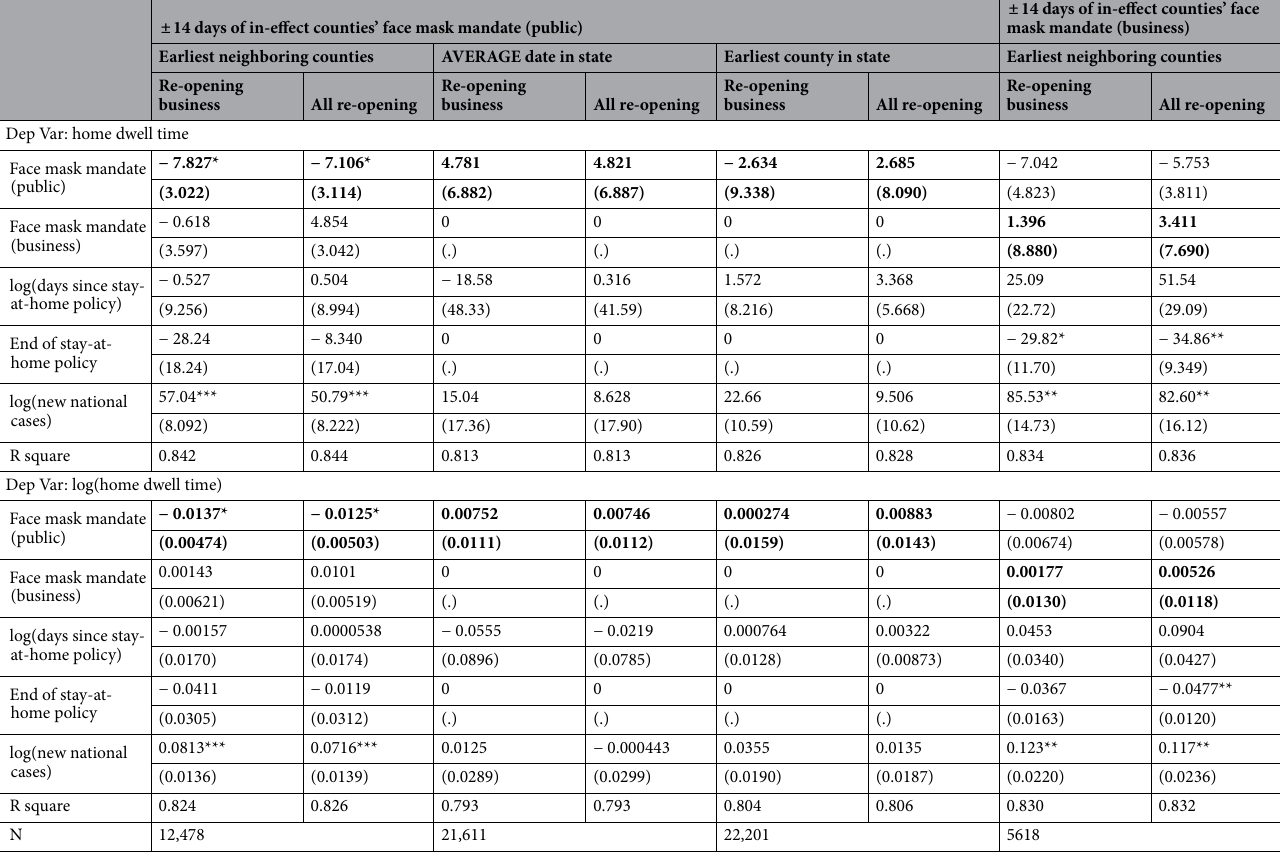
Table 3. Possible face mask mandates spillover effects to no-policy counties. Standard errors are presented in parentheses, one, two, and three asterisks refer to the 95%, 99% and 99.9% confidence level. Bold values are the parameter estimates of primary interest γ 1 and γ 2